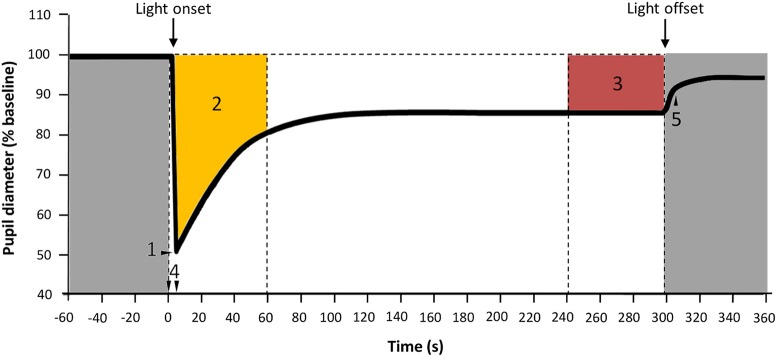
Parameters assessed for PLR. 1: Maximum constriction; 2: Area under the curve from 0 to 60 s of light exposure (AUC0−60, yellow); 3: Area under the curve from 240 to 300 s of light exposure (AUC240−300, red), expressed in A.U.; 4: Time from light onset to the minimum pupil diameter reached during constriction; 5: 6-s PIPR. Gray areas indicate lights off.